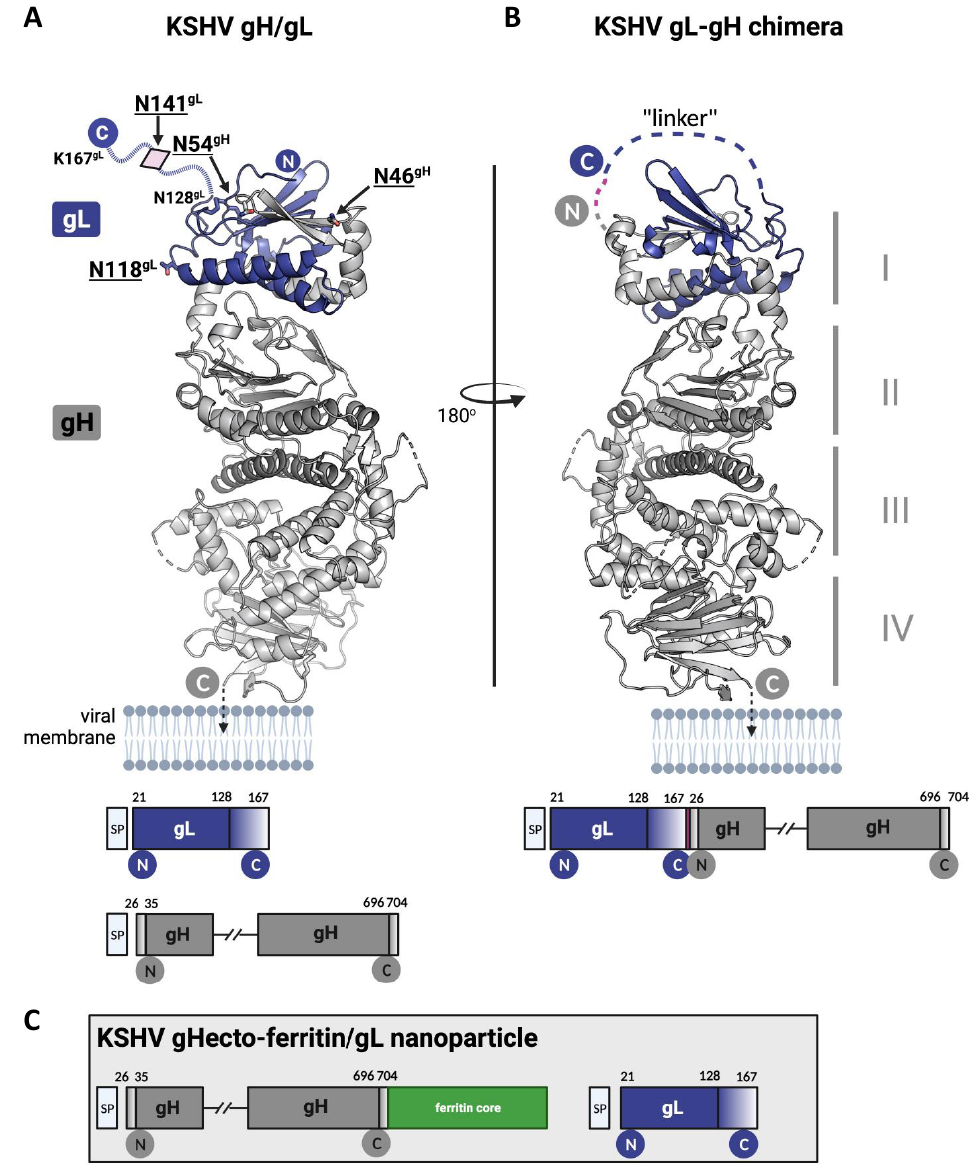
Figure 1. Design of KSHV gHecto/gL immunogens. The gH/gL complex ( A ) and the gL-gH chimera ( B ) are shown on the left and right panels, respectively, with the gHecto-ferritin/gL construct ( C ) in the inlet; I-IV indicate domains; gH is colored in grey and gL in purple, with their N- and C-termini represented as circles containing the letters N and C, respectively. The models are based on the experimentally determined structure of KSHV gH ectodomain/gL complex (PDB:7B7N). The ter- mini of gL (res 129 – 167) and gH (res 26 – 34 and 697 – 704) are not resolved in the structure indicating flexible regions. In the left panel, the putative location of the gL C-terminus (dotted purple line) is shown, with the glycosylation site N141 represented as a pink diamond. The remaining N-glycosyl- ation sites — residues N118 in gL and N46 and N54 in gH — have their side chains represented as stick models. The linker (dashed line on the right panel) that connects the gL and gH in the chimera is formed by the flexible C-terminus of gL (res 129 – 167) that is joined to flexible N-terminus of gH (res 26 – 35) by a TGA sequence (highlighted in magenta). SP stands for signal peptide, which was a part of the expression construct.